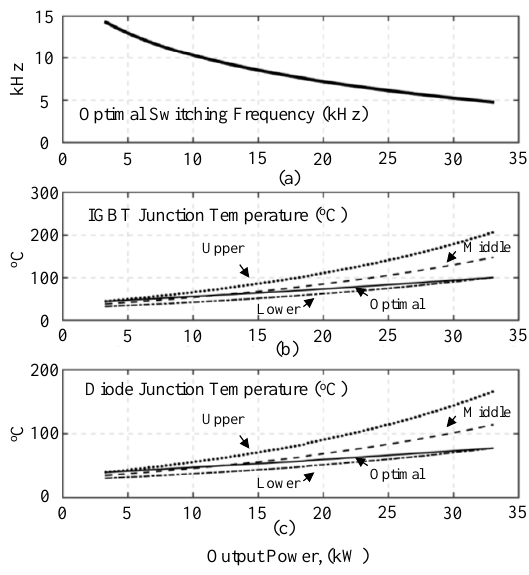
Figure 5. Optimal switching frequency and the junction temperature versus output power for different switching frequencies, ( a ) optimal switching frequency in kHz; ( b ) IGBT junction temperature under different switching frequencies; ( c ) diode junction temperature under different switching frequencies.